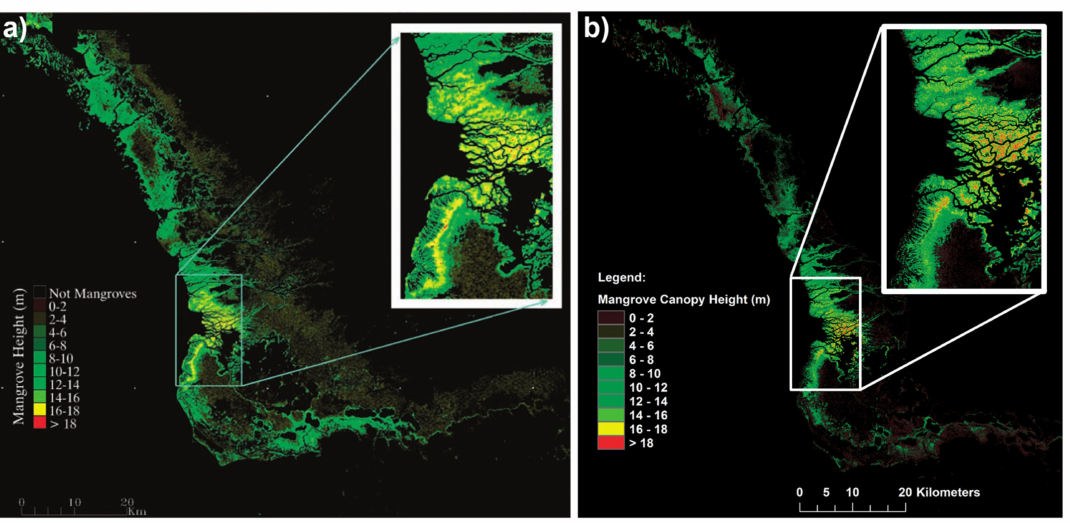
Figure 11. ( a ) Mangrove DCM published by Simard et al. [3] using Shuttle Radar Topography Mission (SRTM) data; ( b ) Mangrove DCM produced in this study using TDX